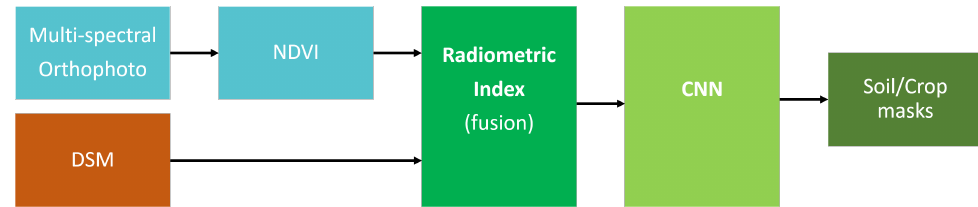
Figure 3. Adopted workflow to combine DSM and multi-spectral orthophoto to feed